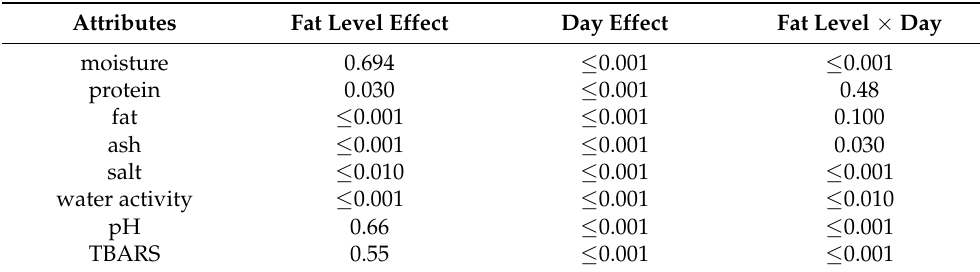
Table 1. Level of statistical significance ( p -values) for the main effects of sheep fat level, day, and their interactions on physico-chemical characteristics and TBARS of zebra droëwors. Attributes Fat Level Effect Day Effect Fat Level × Day moisture 0.694 ≤ 0.001 ≤ 0.001 protein 0.030 ≤ 0.001 0.48 fat ≤ 0.001 ≤ 0.001 0.100 ash ≤ 0.001 ≤ 0.001 0.030 salt ≤ 0.010 water activity ≤ 0.001 TBARS Table 2 shows the physico-chemical characteristics of zebra droëwors made at the different meat:fat ratios (90:10, 85:15, 80:20) before (raw batter) and after drying (day 2). The raw batter made with 20% fat showed a lower moisture and protein content, and a higher fat content compared to the 90:10 and 85:15 treatments. As expected, significant differences were found before and after drying for all the treatments for moisture, protein, fat, ash, salt, a w , as well as for pH because of the weight/moisture loss during drying. The weight loss during drying decreased when fat level increased. This might be due to both the lower moisture content in the raw batter and the higher fat content, as fat may limit moisture transfers during drying. Finally, the moisture content of the droëwors differs only in the 85:15 and the 80:20 treatments (27.91 and 30.45 g/100 g, respectively). Higher weight loss during drying when fat content is decreased in the raw batter at levels close to this study has also been reported for other types of rapidly dried sausages [18] and short ripened fermented sausages [28]. Proximate composition of the droëwors was in the range of values reported on commercial beef, game, and ostrich droëwors [2]. Mean values for fat content ranged between 19.71 and 24.54% after drying, and was higher for the meat fat ratio 80:20 because of the higher fat content in the raw batter and despite the lower weight loss during drying. Protein mean values across treatments were 40.03–46.22 g/100 g in